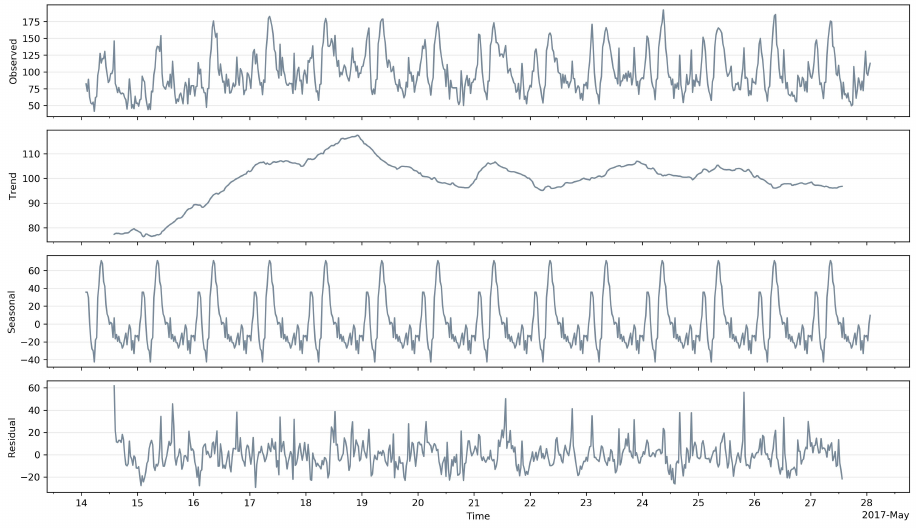
Figure 7. Additive decomposition of flowrate sensor 6 from 15 to 28 May 2017. Table 5. Descriptive statistics of the real sensors from 15 to 28 May